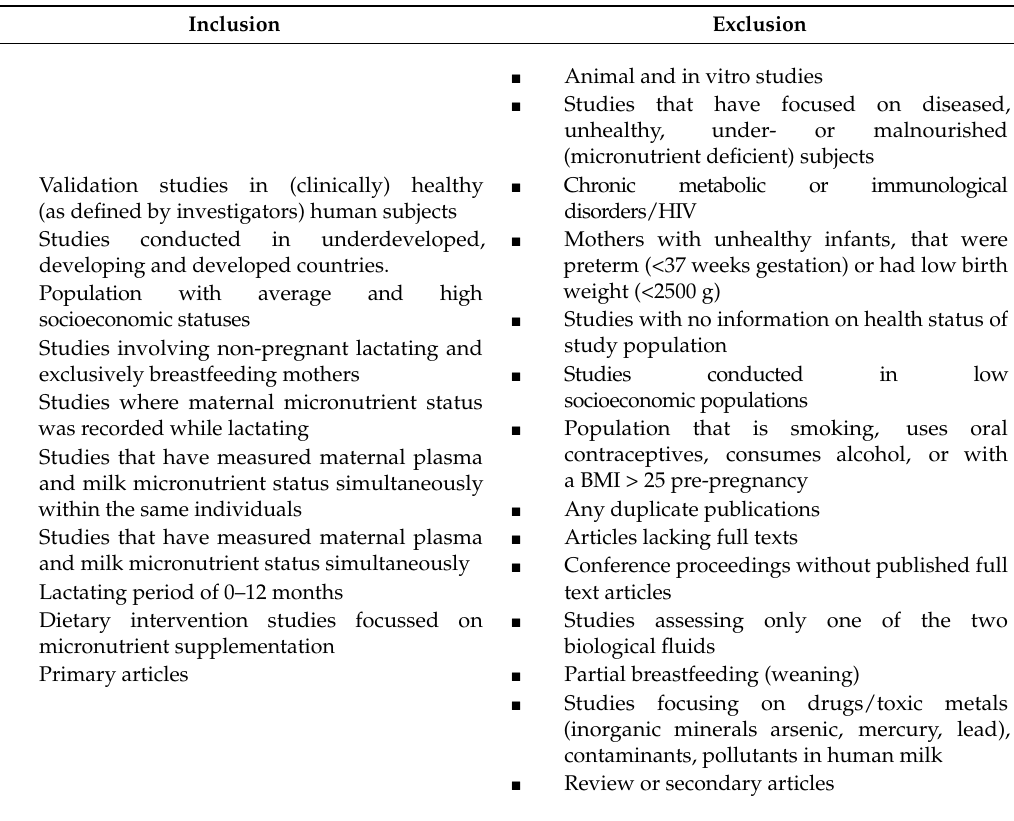
Table 2. Predefined and restricted screening criteria. Along the lines of these inclusion and exclusion measures, titles, abstracts, and full texts were screened for